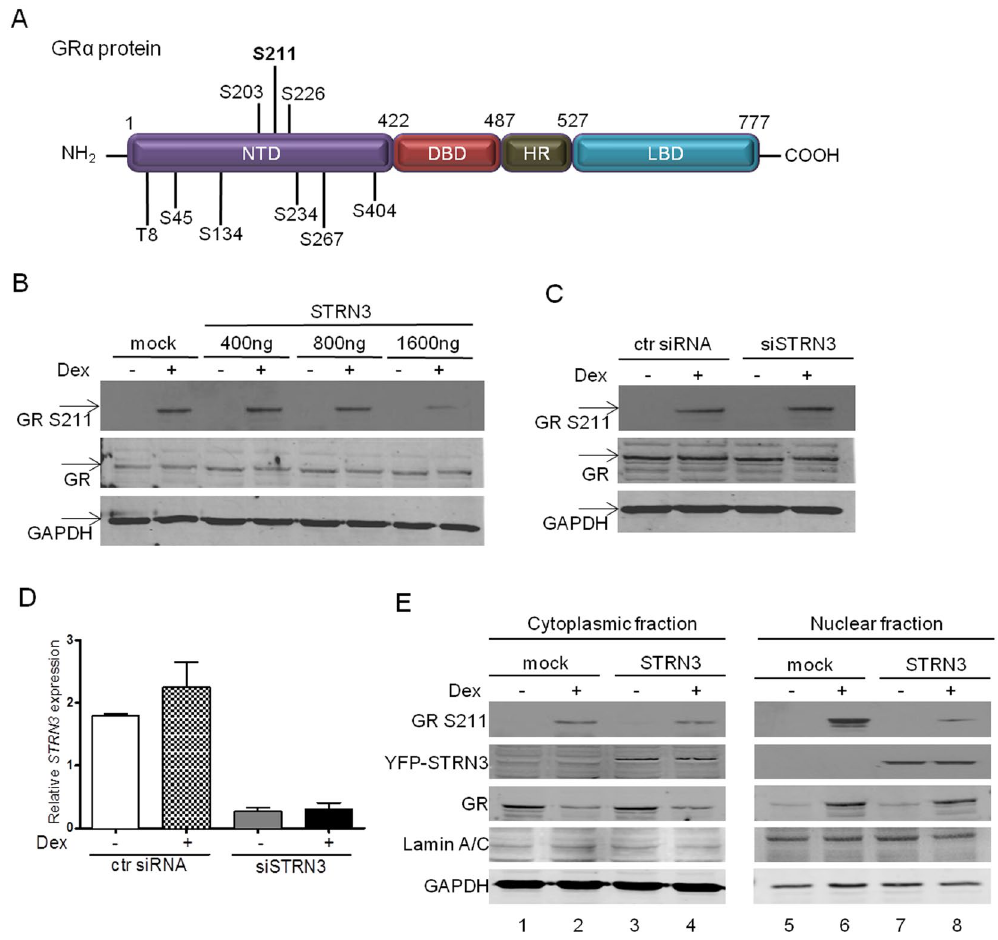
Figure 5. STRN3 mediates the dephosphorylation of GR at serine 211. ( A ) Protein structure of human GR with its respective domains (NTD, DBD, HR, LBD) and the phosphorylation sites indicated (S, serine, T, threonine). ( B ) A549 cells were transfected in 6-wellplate with gradient amounts of YFP-STRN3 plasmid, 400 ng, 800 ng, 1600 ng or mock DNA (empty vector was used so that total transfected DNA is 2 μ g/well) and stimulated with vehicle ( − ) or 1 μ M Dex ( + ) for 2 h. The cells were lysed and processed for immunoblotting against GR phosphorylated at S211 (GR S211), total GR (86 kDa) and GAPDH (36 kDa). ( C ) A549 cells were transfected with 50 nM of STRN3-specific siRNA in 6-wellplate and stimulated with vehicle ( − ) or with 1 μ M Dex ( + ) for 2 h. Samples were processed either for immunoblotting against GR phosphorylated at S211, total GR and GAPDH (The blots show one representative experiment out of three performed) or for ( D ) RNA isolation and qPCR to determine the endogenous levels of STRN3 and the efficiency of STRN3 silencing (statistics are not performed as data represent a technical triplicate). ( E ) YFP-STRN3 (or mock plasmid, empty vector) was over-expressed in A549 cells at a concentration of 6 μ g in 10 cm plates and stimulated with vehicle ( − ) or with 1 μ M Dex ( + ) for 2 h. Cells were lysed and separated into cytoplasmic and nuclear fractions. Cellular fractions were analyzed by gel electrophoresis and immnunoblotted using antibodies against GR phosphorylated at S211, total GR (86 kDa), (YFP-) STRN3 (122 kDa), Lamin A/C (70 kDa, nuclear marker) and GAPDH (36 kDa, cytoplasmic marker). The blots show one representative experiment out of three performed (full-length blots of 5B, 5C and 5E are provided in Supplementary S12, S13 and S14,